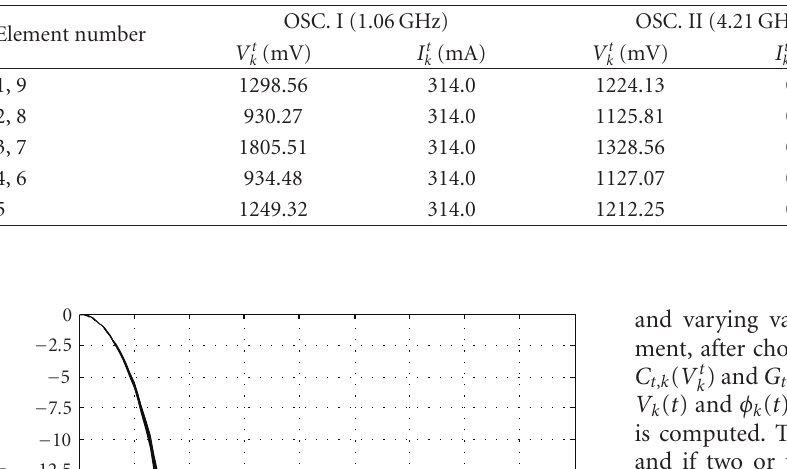
Table 7: The tuning parameters for the constant amplitude design case.